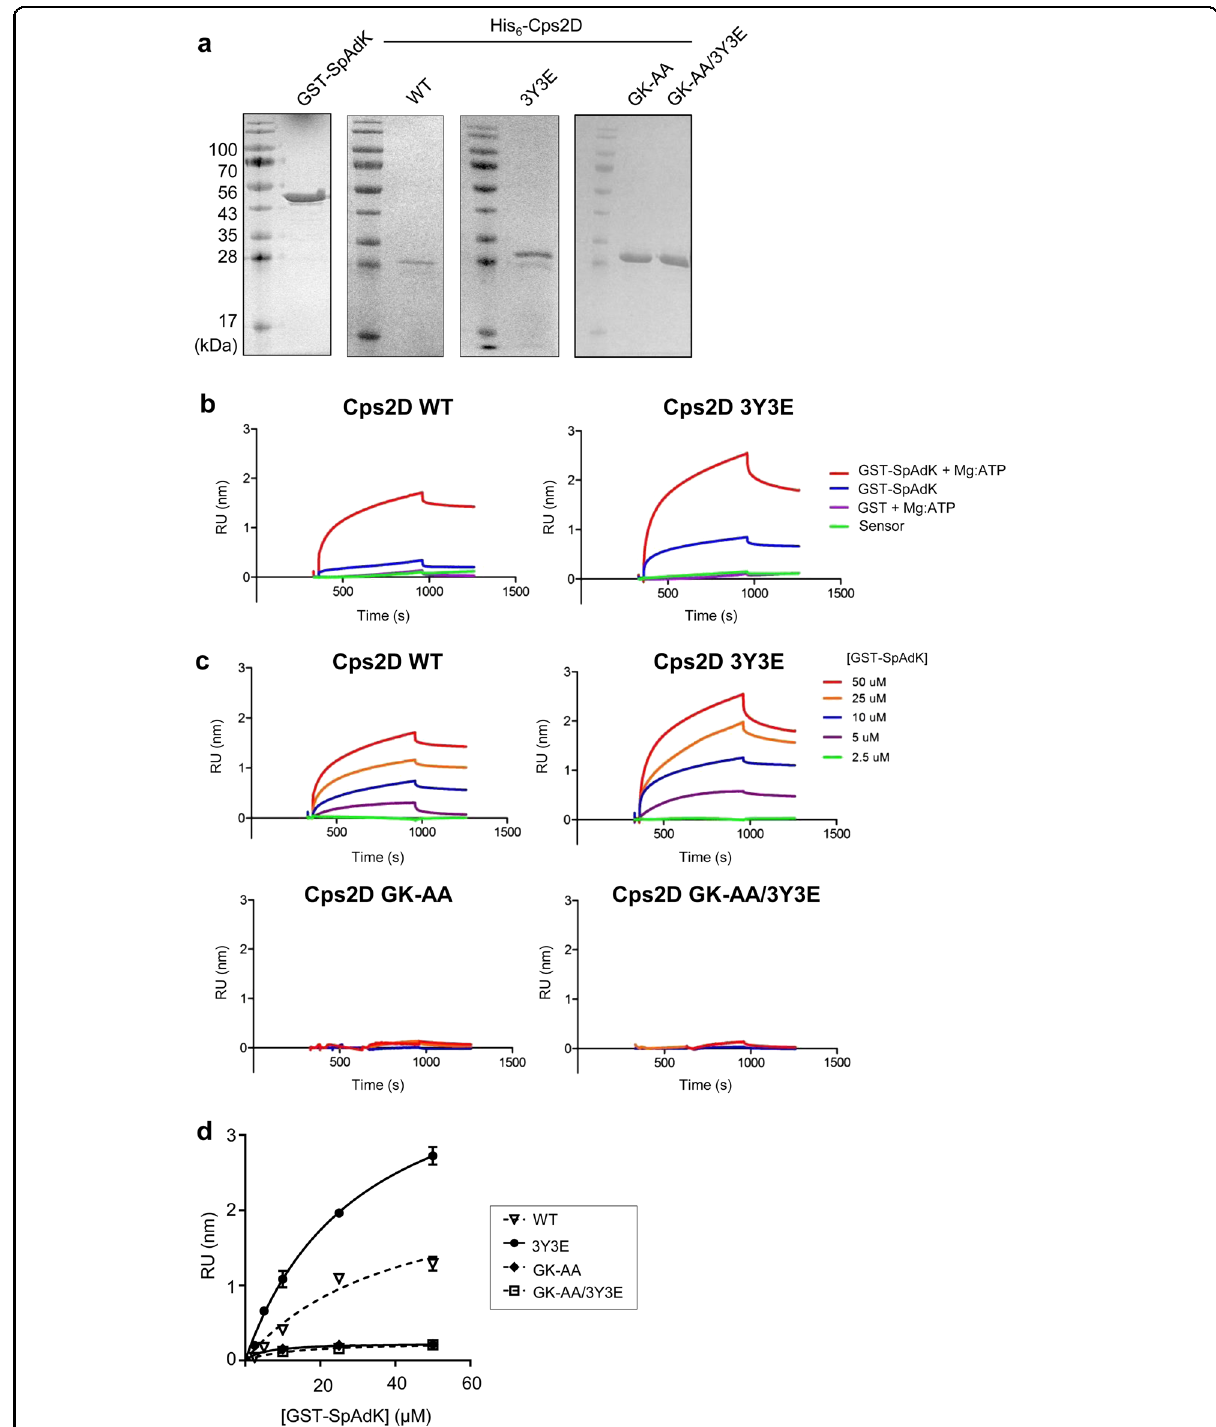
Fig. 5 Cps2D ATP-binding domain is required for direct interaction with SpAdK. a SDS-PAGE gels showing puri fi ed recombinant GST-SpAdK, His 6 -Cps2D wild-type (WT), 3Y3E (Y215E/Y218E/Y221E), GK-AA (G48A/K49A), and GK-AA/3Y3E. b BLI sensorgrams of the interactions between SpAdK and Cps2D WT or 3Y3E in the presence or absence of ATP. For clarity, only sensorgrams at the maximal concentration of Cps2D protein (50 μ M) are shown. c BLI sensorgrams of the interaction between SpAdK with Cps2D. His 6 -Cps2D was immobilized on Ni-NTA sensors, followed by the addition of varying concentrations of GST-SpAdK (2.5, 5, 10, 25, and 50 μ M). RU response unit. d BLI-derived binding curves for the interactions of SpAdK with Cps2D WT, 3Y3E, GK-AA, and GK-AA/3Y3E mutants for steady-state binding analysis. The data are representative of two independent